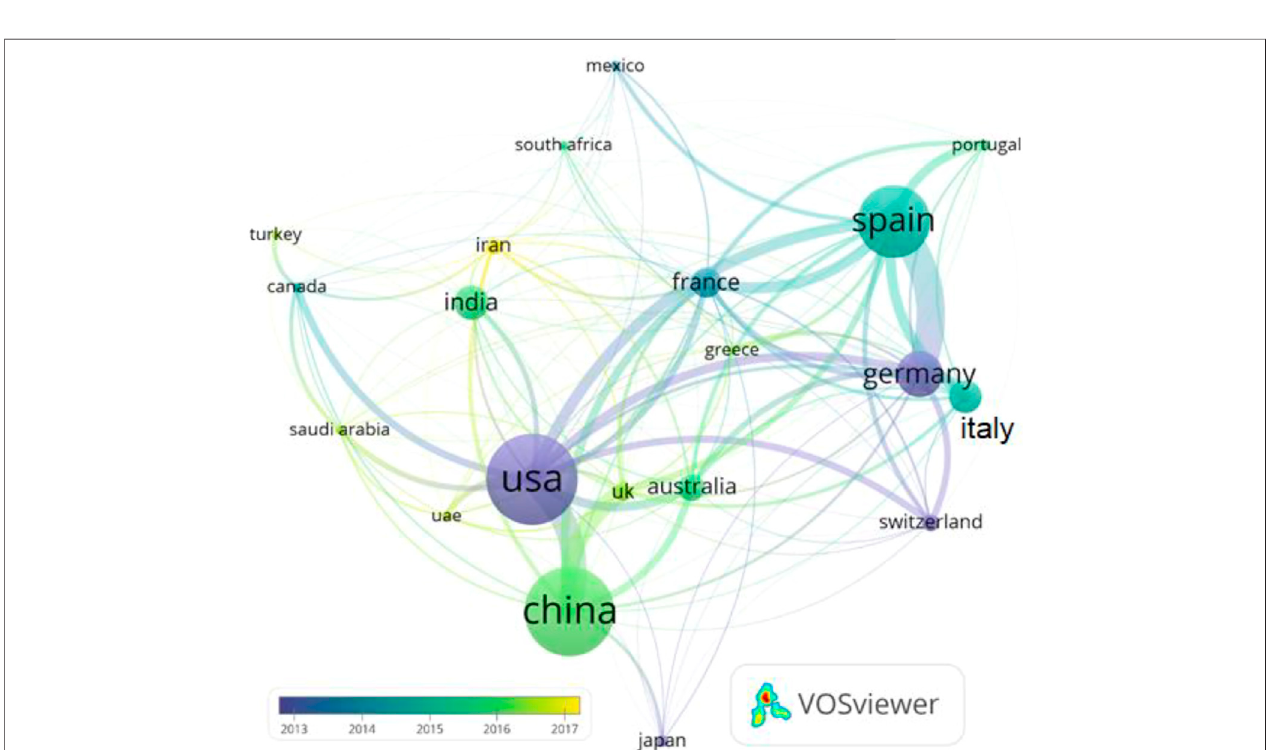
FIGURE 5 | Country co-authorship interaction collaboration of the Top20 countries.